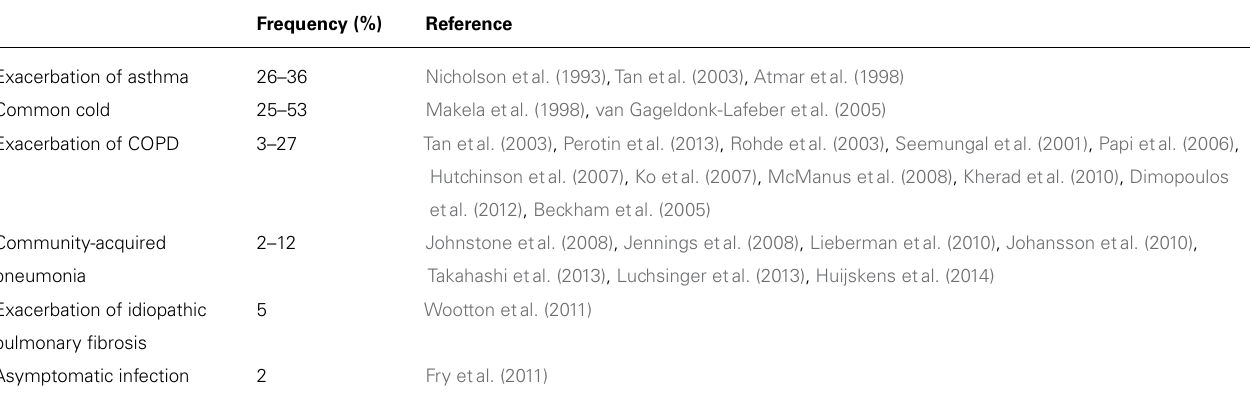
Table 1 | HRV infection and its frequency in acute and chronic respiratory diseases in adults.